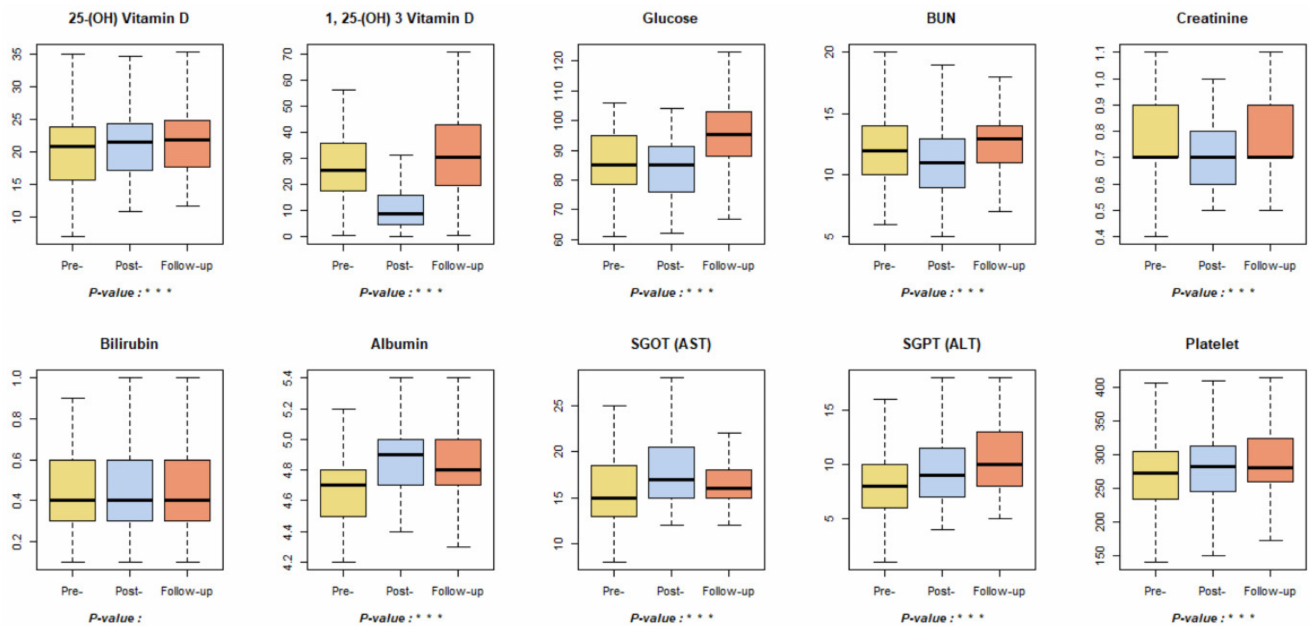
Figure 9. Results of health screening-related indicators. *** p < 0.001. Pre-: daily health conditions two weeks prior to the forest healing program; Post-: health conditions immediately after the forest healing program; Follow-up: daily health conditions one, two, and four weeks after the forest healing program; BUN: blood urea nitrogen; SGOT: serum glutamic oxaloacetic transaminase; AST: aspartate aminotransferase; SGPT: serum glutamic pyruvic transaminase; ALT: alanine aminotransferase.